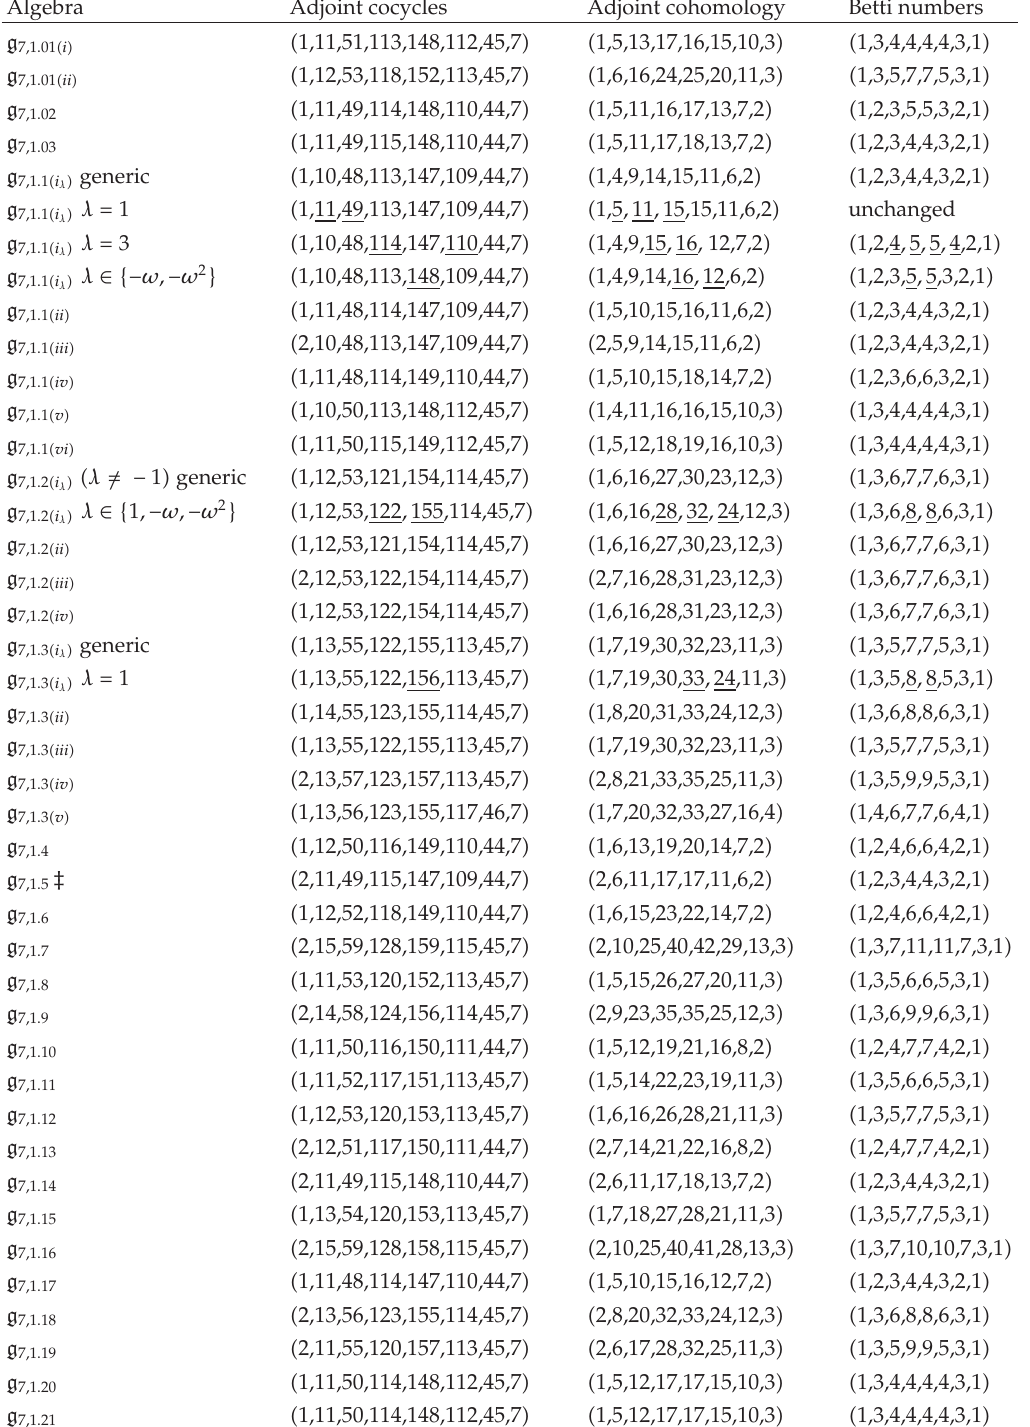
Table 4: Cohomology table for NLAs of dimension 7: rank